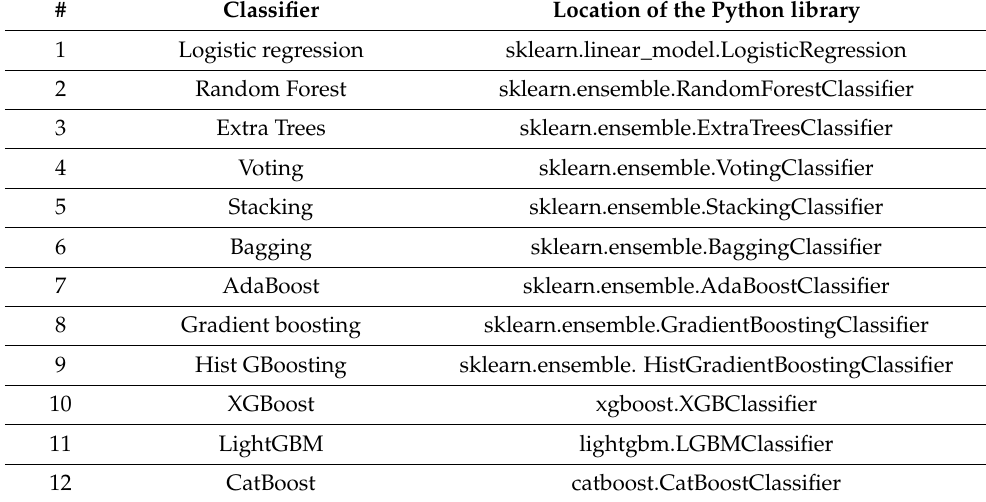
Table 2. List of classifiers with their